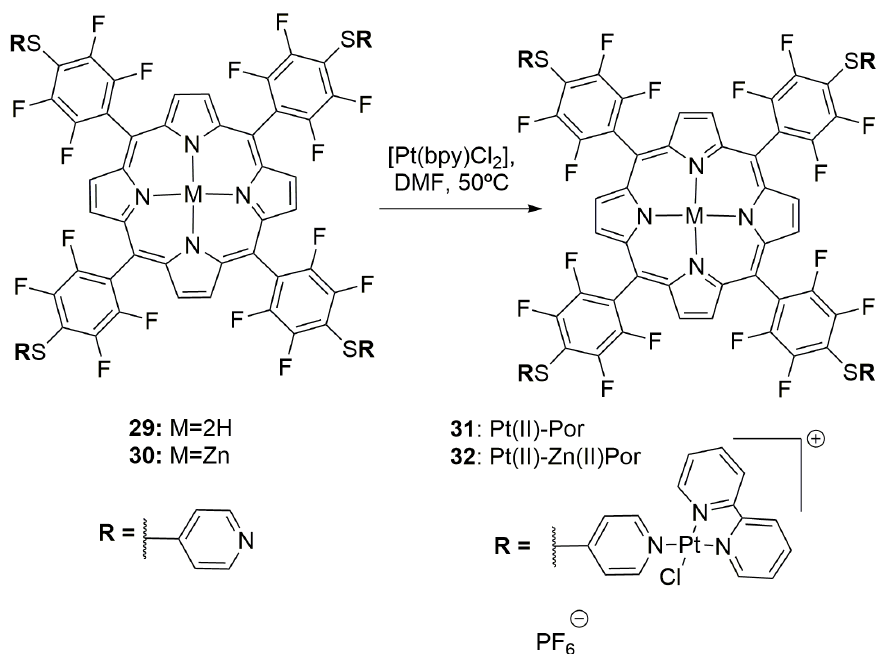
Figure 28 - Synthesis of tetra-platinum(II)-thiopyridylporphyrins 31 and 32 .